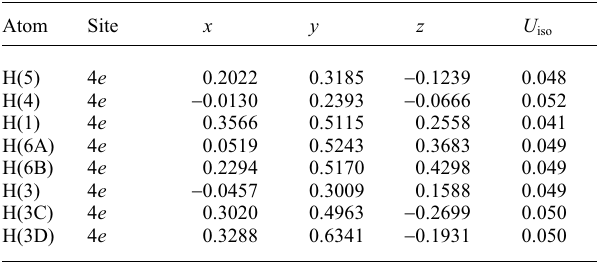
Table 2. Atomic coordinates and displacement parameters (in Å 2 )